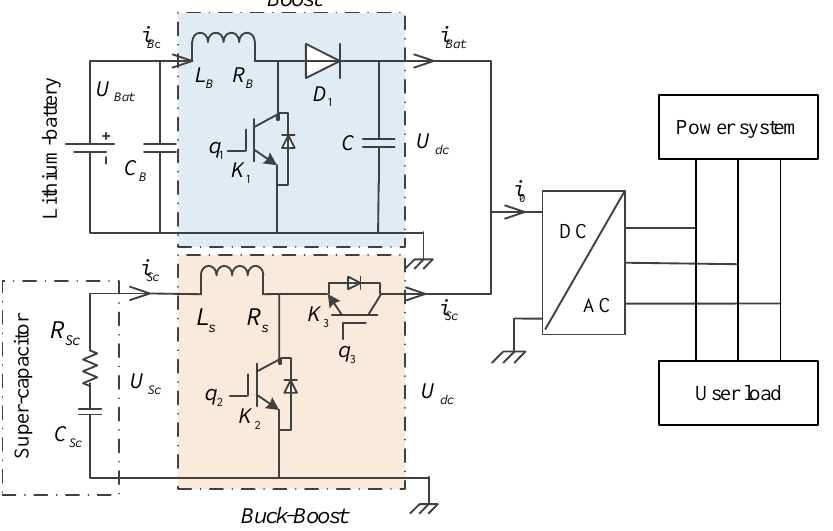
Figure 3. Basic structure of the hybrid energy storage system.